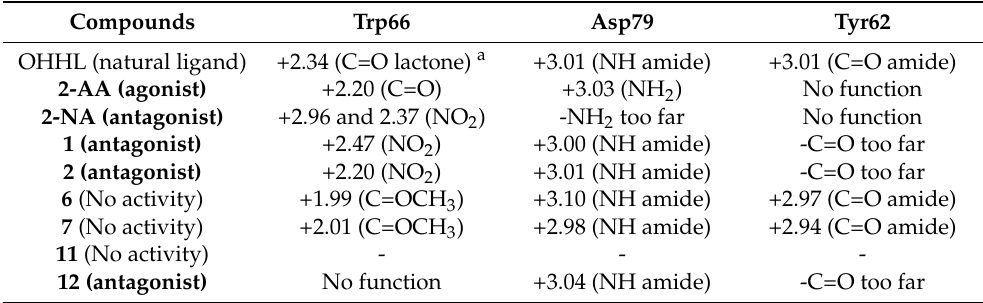
Table 1. Occurrence and distances for hydrogen bonds between Trp66, Asp79, and Tyr 62 and the main chemical functions of studied compounds with distances (Å) a,b .